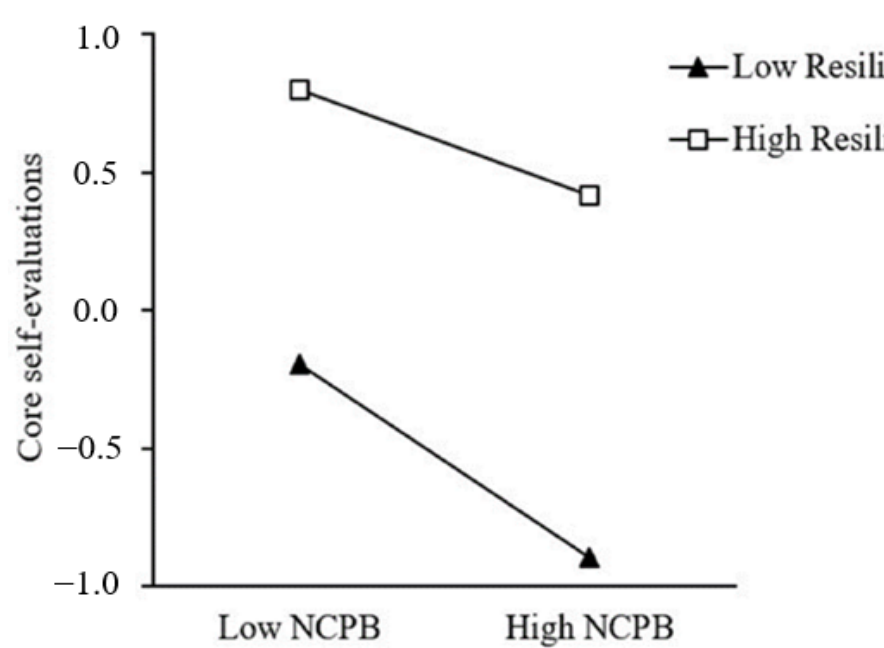
Figure 4. Resilience moderates the relation between negative cognitive processing bias and core self- evaluations.